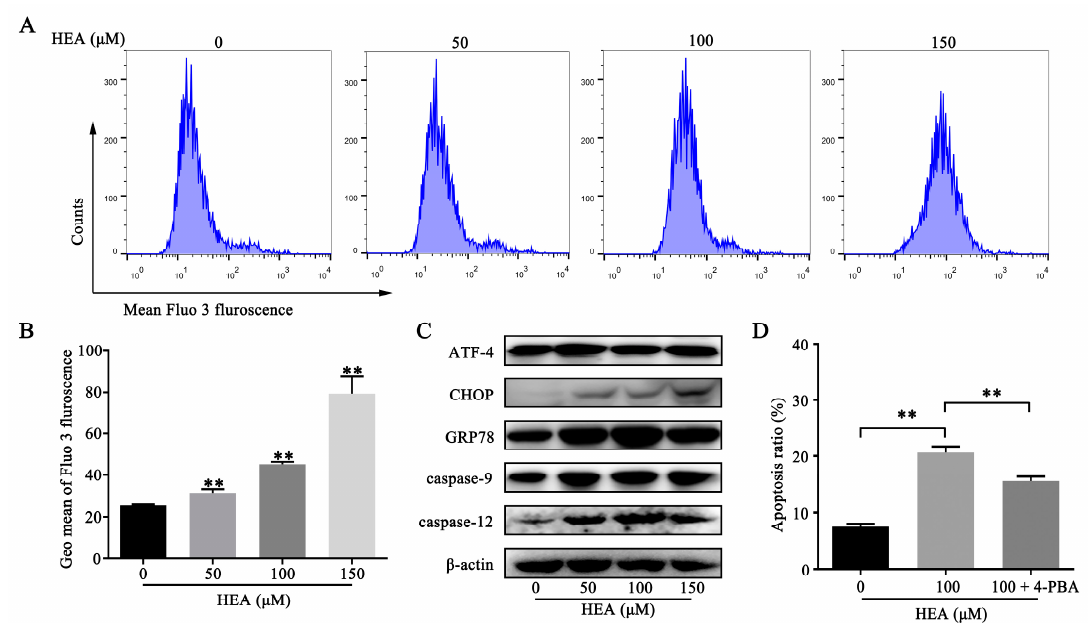
Figure 4. HEA-induced ER stress of SGC-7901 cells. ( A ) Cells were treated with HEA for 48 h, and intracellular Ca 2 + was measured using Fluo-3 AM probe. ( B ) Histogram of average Fluo-3 AM, indicated by Geo Mean. ( C ) Western blot analysis of HEA on the expressions of ER stress-related proteins. ( D ) Columns for apoptotic SGC-7901 cells incubated with vehicle, HEA (100 µ M), HEA (100 µ M) + 4-PBA (1 mM), and ER stress inhibitor 4-PBA and HEA had those compounds added 48 h before the apoptosis detection assay. ** p < 0.01 compared with 0 µ M HEA group, three repeats per group.